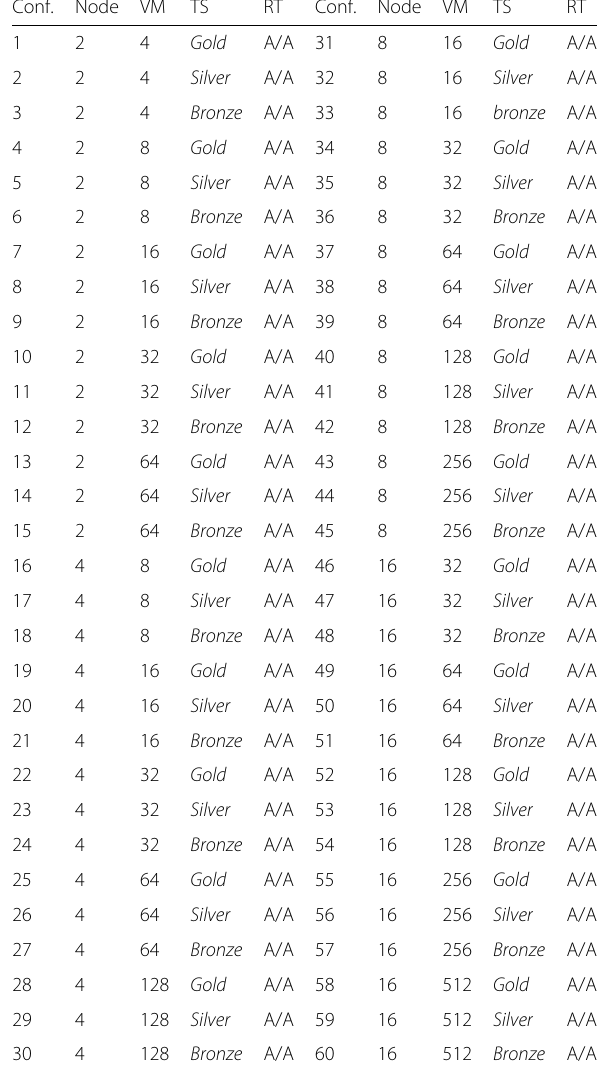
Table 15 Planning for design of experiments of the third